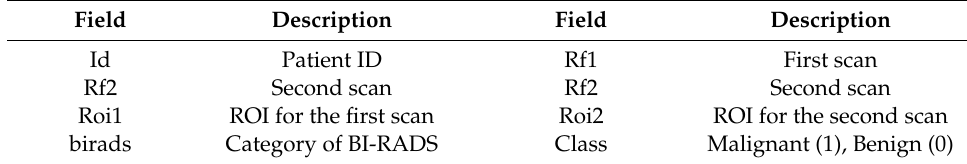
Table 1. Structure of Open Access Series of Breast Ultrasonic Data (OASBUD) dataset.